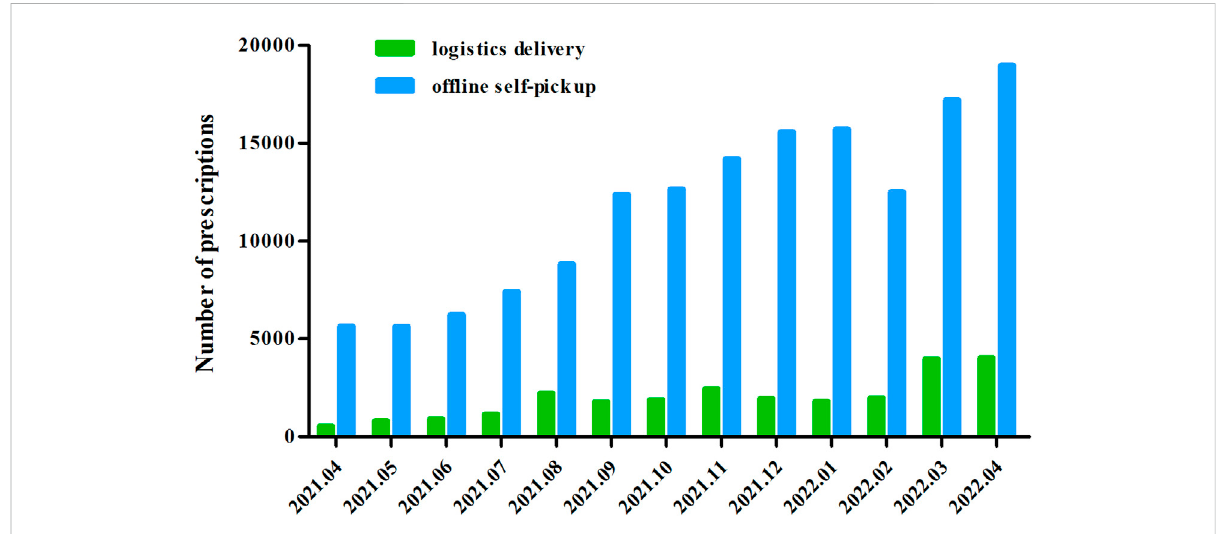
FIGURE 4 Comparison of the number of prescriptions between “ logistics delivery ” and “ of fl ine self-pick up.